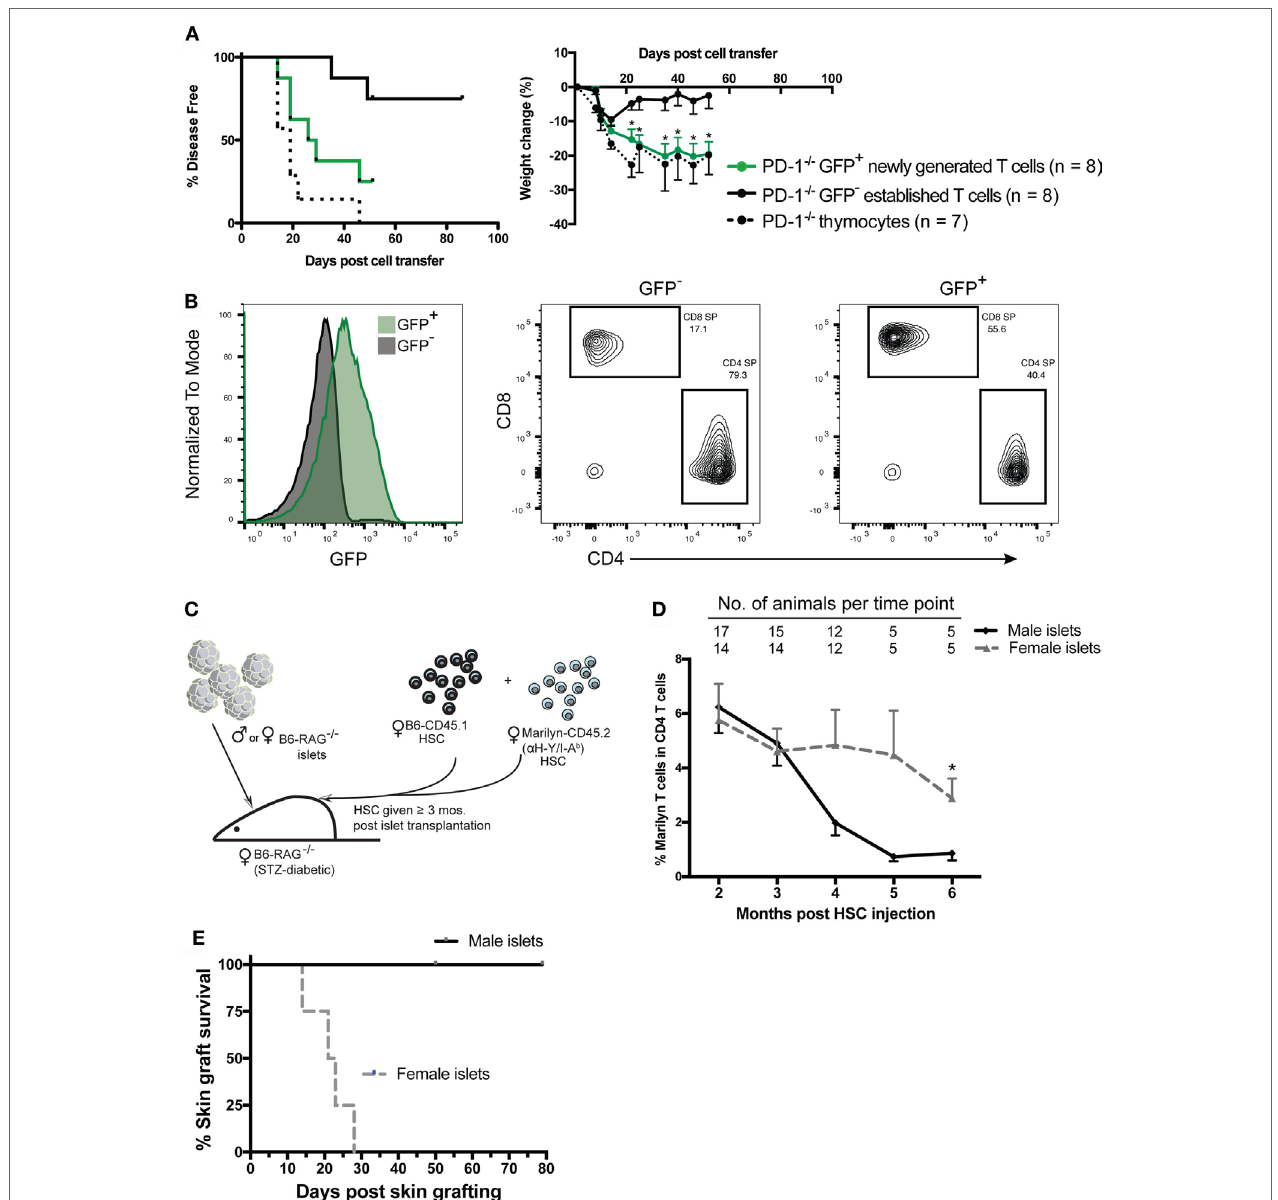
FigUre 2 | Peripheral PD-1 − / − newly generated T cells preferentially drive autoimmunity in lymphopenic recipients. CD4 and CD8 single positive (SP), GFP + , and GFP − cells were sorted from ~6-week-old Rag2pGFP × PD-1 − / − splenocytes. 1 × 10 6 sorted CD4 and CD8 SP GFP + or GFP − cells, or unfractionated thymocytes containing an equivalent number of CD4 and CD8 SP cells (~8–9 × 10 6 ) were injected into NK depleted adult Rag − / − recipients and mice were monitored for disease symptoms. (a) Left panel: disease incidence in recipients of thymocytes, GFP + newly generated T cells or GFP − established T cells. Survival curve comparison demonstrated a significant difference between the three groups with p = 0.003; PD-1 − / − GFP + newly generated cell recipient vs. established cell recipient curves p = 0.02; PD-1 − / − thymocyte recipient vs. PD-1 − / − GFP + newly generated cell recipient curves, p = NS. Data are combined from two independent experiments, starting n values are indicated in the legend. Right panel: weight changes in recipients of indicated cells from two independent experiments ± SEM. Weight observations for which similar time points were available between experiments ( ± 2 days) were combined and used for this analysis. * p < 0.05, GFP + newly generated T cells vs. GFP − established T cells, one-way ANOVA with Tukey’s multiple comparison test. (B) Representative GFP expression (left panel) and CD4 and CD8 SP proportions (right 2 panels) in purified cell populations used in (a) . (c) Diagram of experimental approach using an established minor mismatched transplant as a model peripheral neo-self antigen and anti-donor (HY) TCR transgenic (Tg) Marilyn T cells to track the frequency of CD4 T cells specific to the “neo-self” antigen over time. Male (or control female) islet transplants were allowed to heal ≥ 3 months into streptozotocin (STZ)-induced diabetic female Rag − / − recipients prior to immune reconstitution via transfer of female hematopoietic stem cells (HSC) from CD45 congenic wild-type (B6-CD45.1) and monoclonal TCR Tg mice. (D) Frequency of Marilyn T cells (CD4 + CD45.2 + CD45.1 − V β 6 + ) within total CD4 T cells in the peripheral blood of recipients with male vs. female islets that maintained normoglycemia is shown (mean, SEM, and n for each time point is shown). * p < 0.05, Student’s t -test. (e) Six months post fetal liver cell injection, male skin grafts were transplanted to normoglycemic Rag − / − recipients that had either a male ( n = 5) or female ( n = 4) islet transplant and grafts were monitored for rejection. Survival curves are significantly different with p = 0.018, Mantel–Cox